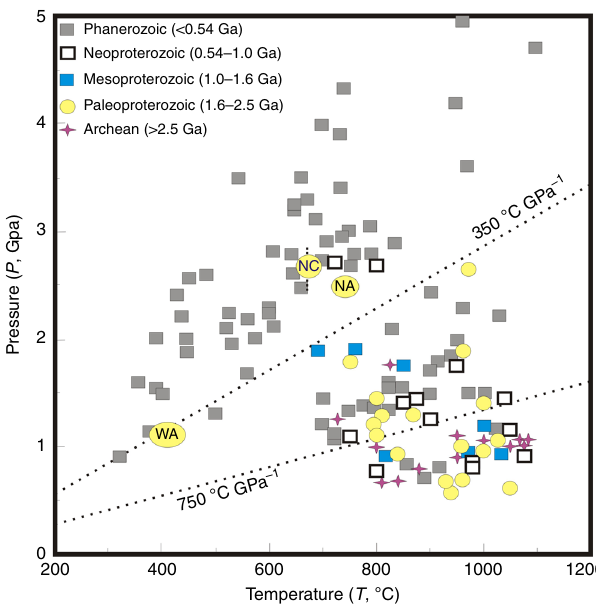
Fig. 3 Peak pressure – temperature condition of this study compared to a global compilation of metamorphic belts. The P – T – t data of these metamorphic belts are indicated by different symbols (see legend) and grouped into three types of metamorphism 2 : high- and ultrahigh-pressure metamorphism (<350°C GPa − 1 ); eclogite and high-pressure granulite metamorphism (<750 °C GPa − 1 ); and granulite and ultrahigh-temperature metamorphism (>750 °C GPa − 1 ). A Paleoproterozoic thermal gradient of <350 °C GPa − 1 was recorded in the high-pressure metamorphism from North China (NC), West Africa (WA) 3 , and North America (NA) 6